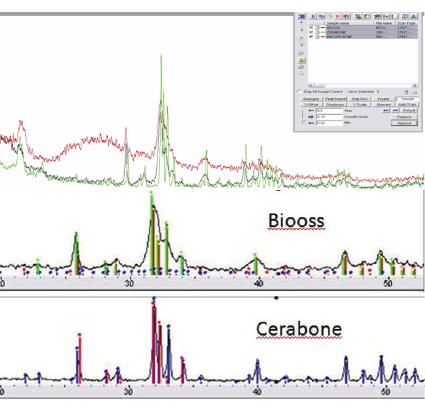
Figure 3: XRD analysis of Bio-Oss (red) and Cerabone (green) in relation to natural hydroxylapatite (black).